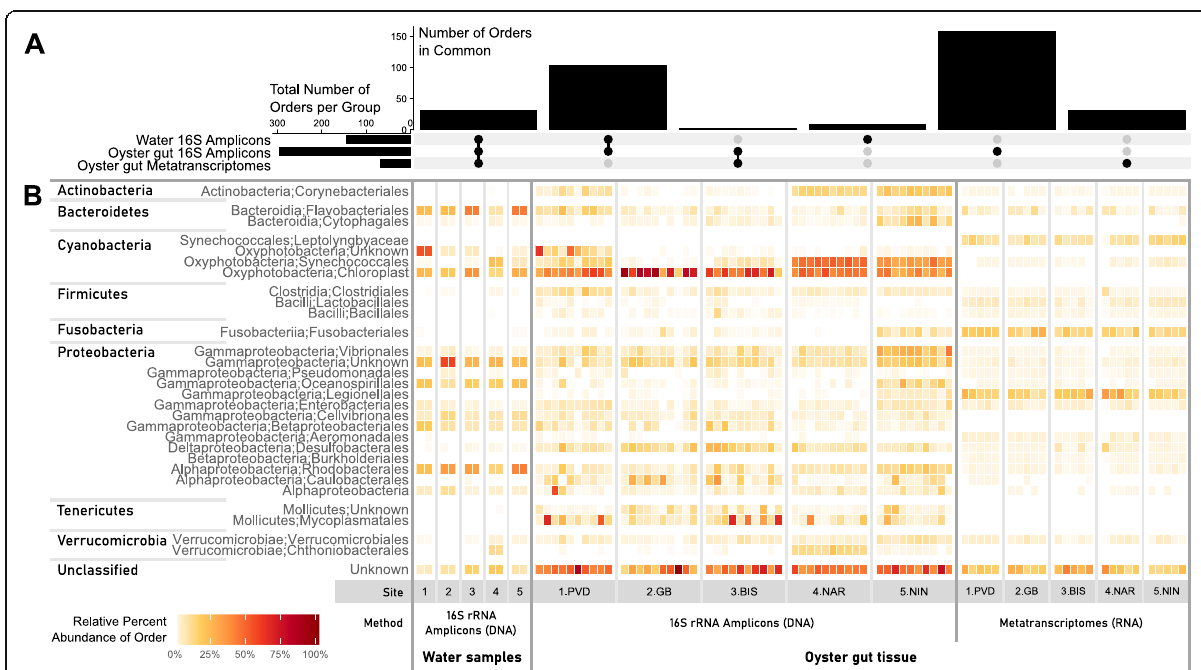
Fig. 4 Effect of site and sample type on present and active bacterial community structures. a Number of bacterial Orders shared between the water 16S rRNA gene amplicons, oyster gut 16S rRNA gene amplicons, and oyster gut metatranscriptomes (vertical bars). The total number of Orders found in each group is shown in the horizonal bar graph on the left. b Relative percent abundances (square root rescaled) of top 30 bacterial Orders associated with seawater samples ( n = 2) or oyster gut tissue ( n = 10 or 5), per site. The most abundant bacteria (16S rRNA gene amplicons, middle, n = 10) and the most transcriptionally active bacteria (metatranscriptomes, right, n = 5) in the oyster gut are